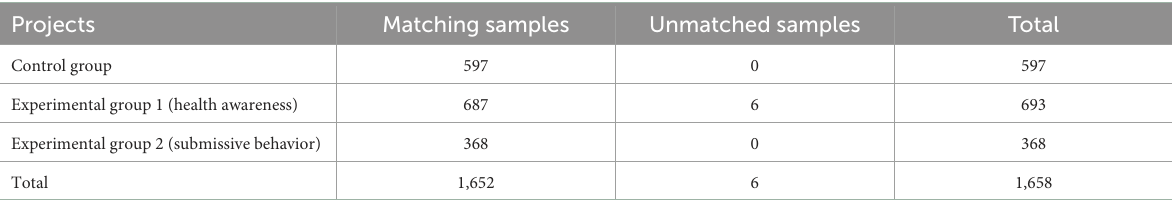
TABLE 4 PSM matching